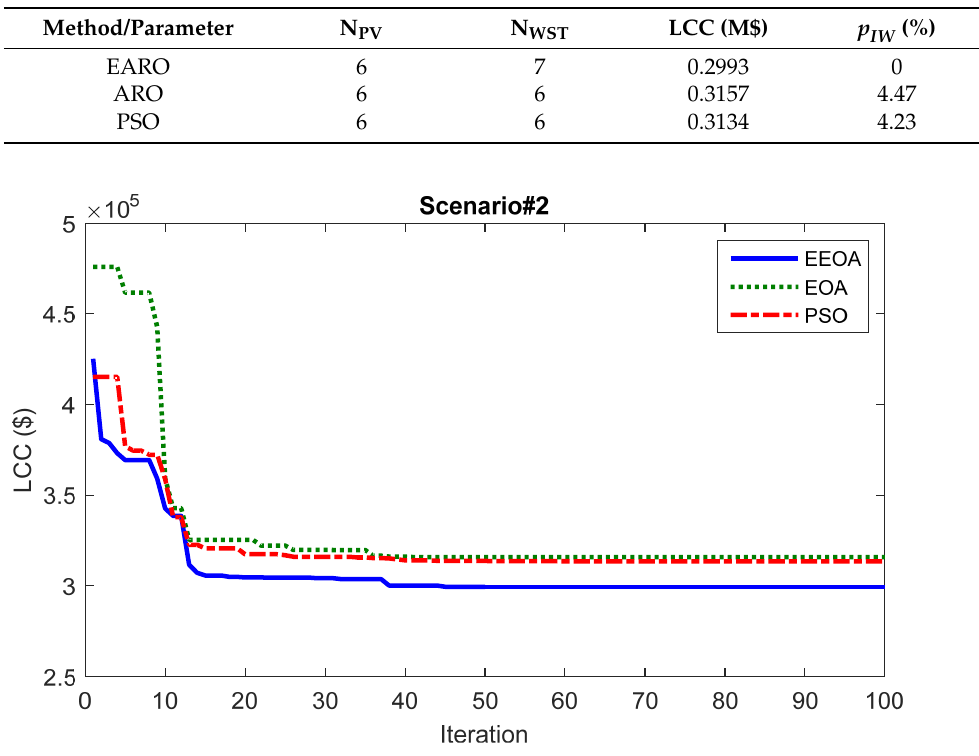
Figure 9. The EARO, ARO, and PSO convergence curves in the second scenario. Figure 8. The EARO, ARO, and PSO convergence curves in the second Table 8. System optimization results in the second scenario.